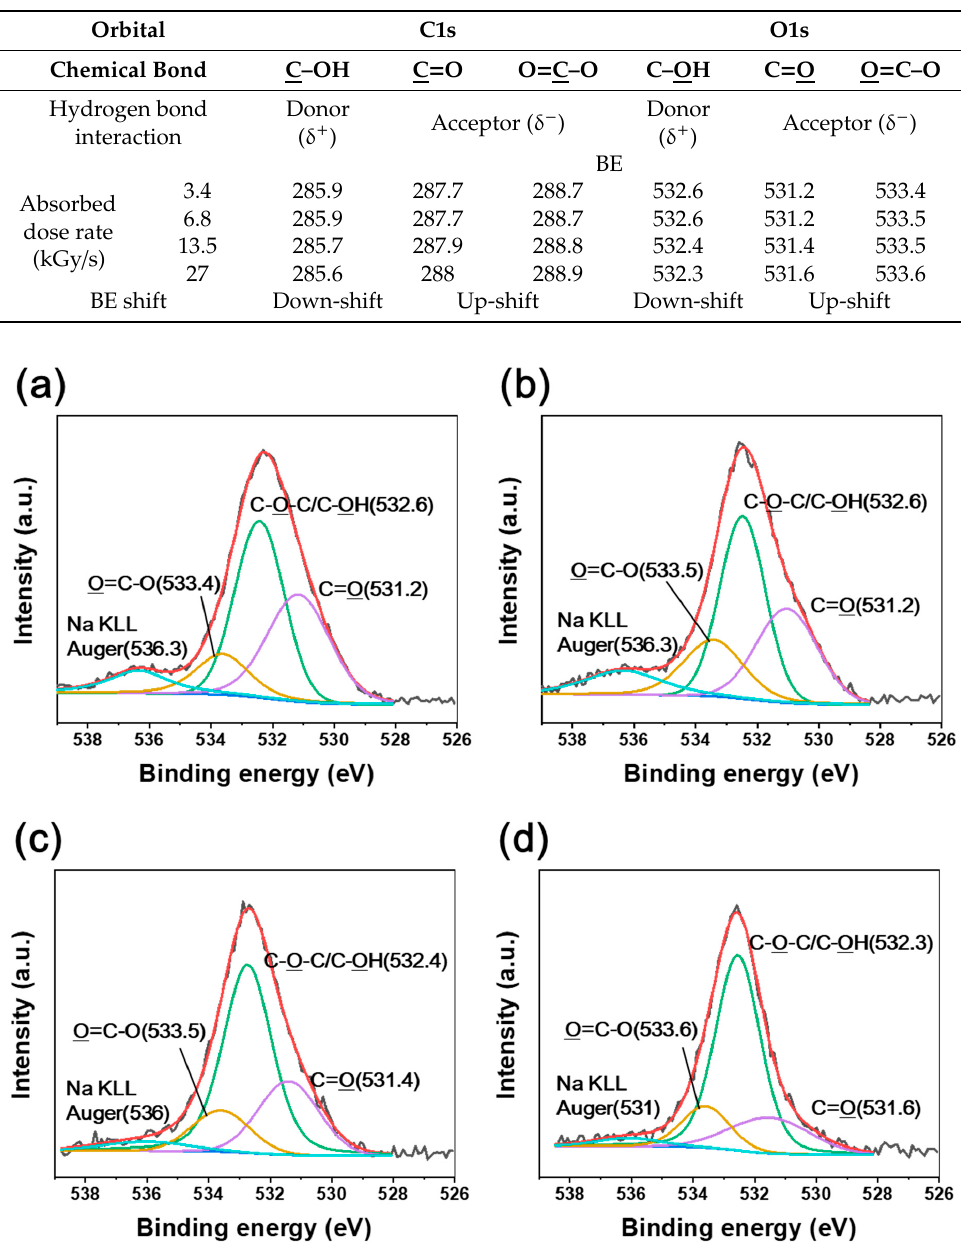
Table 3. C1s and O1s binding energies of irradiated CFRTPs for various absorbed dose rates.